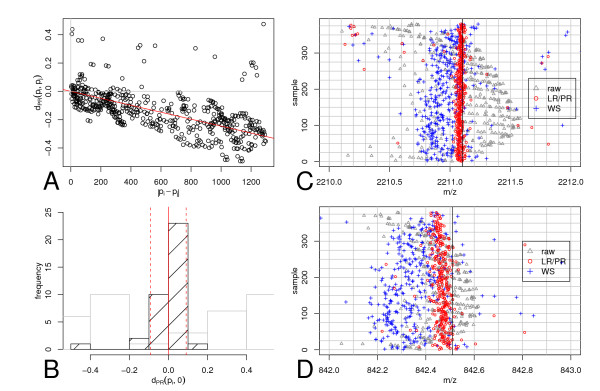
Principle and results of linear regression on peptide rule LR/PR calibration. Panel A: Scatter-plot of ΔPR (mi, mj) (Equation 31) in dependence of Δd = |mi - mj|. The slope, obtained by robust regression, is shown by the red line. Panel B: Histogram (black with diagonals) of dPR(mi, 0). The continuous vertical red line denotes the average (d¯
 MathType@MTEF@5@5@+=feaafiart1ev1aaatCvAUfKttLearuWrP9MDH5MBPbIqV92AaeXatLxBI9gBaebbnrfifHhDYfgasaacH8akY=wiFfYdH8Gipec8Eeeu0xXdbba9frFj0=OqFfea0dXdd9vqai=hGuQ8kuc9pgc9s8qqaq=dirpe0xb9q8qiLsFr0=vr0=vr0dc8meaabaqaciaacaGaaeqabaqabeGadaaakeaacuWGKbazgaqeaaaa@2E15@PR(mi, 0)) and the dotted vertical lines denote (d¯
 MathType@MTEF@5@5@+=feaafiart1ev1aaatCvAUfKttLearuWrP9MDH5MBPbIqV92AaeXatLxBI9gBaebbnrfifHhDYfgasaacH8akY=wiFfYdH8Gipec8Eeeu0xXdbba9frFj0=OqFfea0dXdd9vqai=hGuQ8kuc9pgc9s8qqaq=dirpe0xb9q8qiLsFr0=vr0=vr0dc8meaabaqaciaacaGaaeqabaqabeGadaaakeaacuWGKbazgaqeaaaa@2E15@PR(mi, 0) ± SN. The histogram in gray is showing the distribution of (dPR(mi, 0) previous to removing the slope error (see text). Panel C & D: Strip-charts of the data-set for a mass range of 2210 – 2212Da and 842 – 843Da, including the tryptic autolysis peaks 842.508Da and 2211.100Da. Gray triangles – raw data; blue "+" – Wool Smilansky algorithm (cf. Appendix); red "o" – LR/RP algorithm for tryptic peaks .